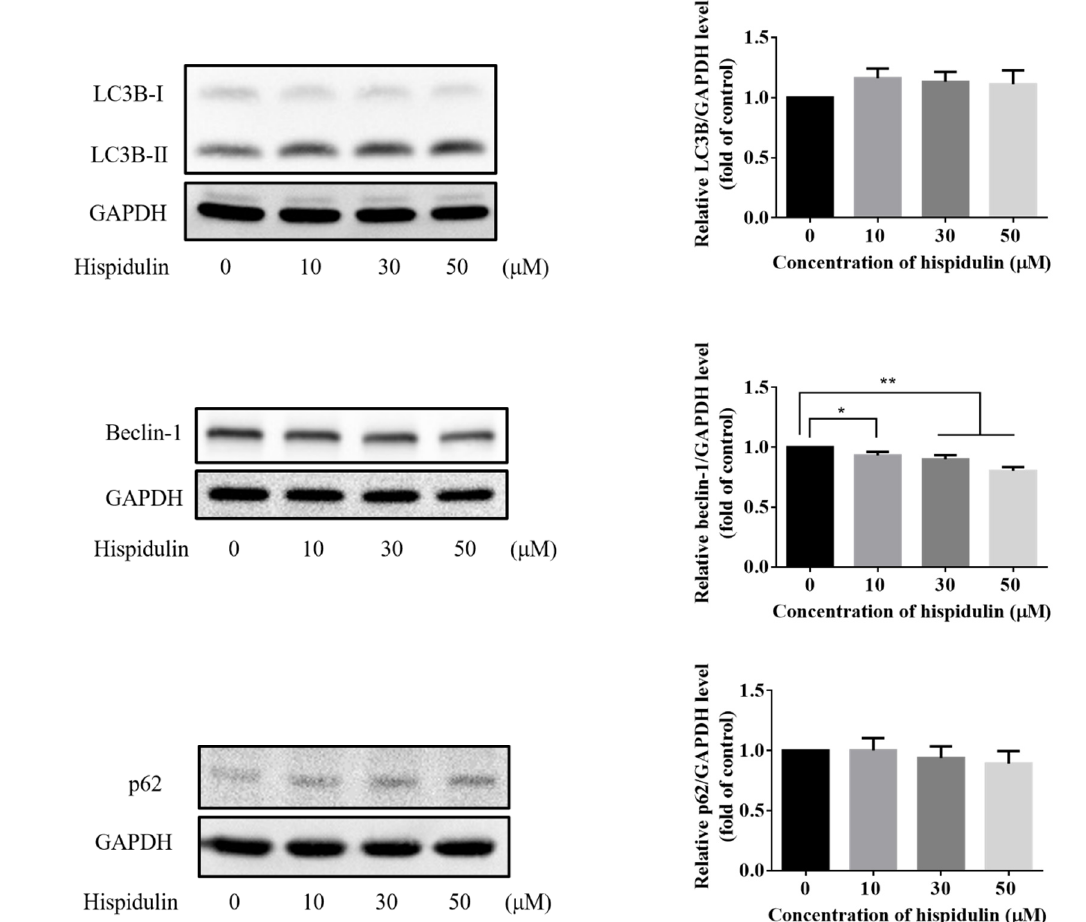
Figure 5. The expression of LC3B-I/LC3B-II, Beclin-1, and p62/SQSTM (p62) were assessed by Western blotting in A2058 cells treated with the indicated concentration of hispidulin or DMSO (control) for 24 h. Data were presented as fold of control and mean ± SE, with * p < 0.05 and ** p < 0.01 compared with the untreated control group (n = 5).